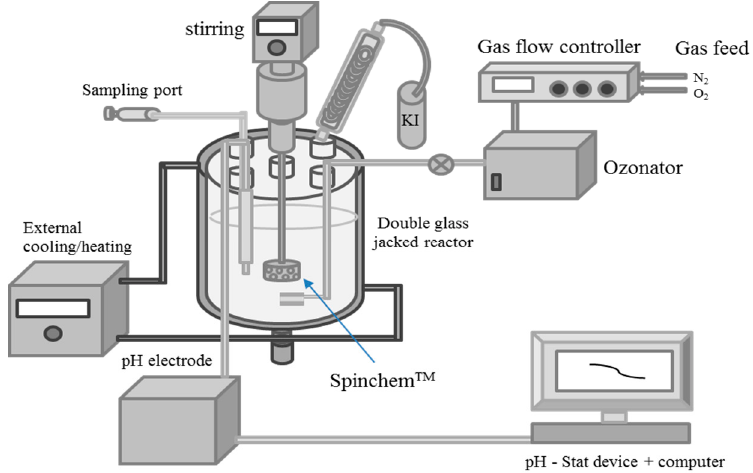
Figure 12. Scheme of the semi-batch reactor system for the evaluation of heterogeneous catalysts in the degradation of ibuprofen.